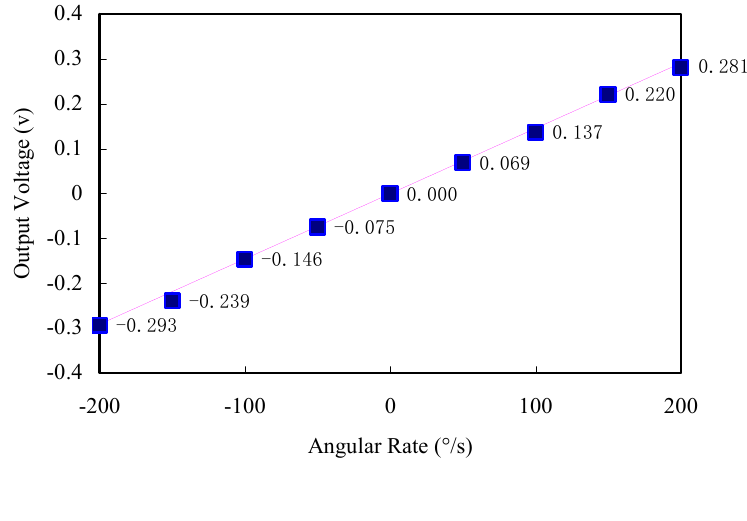
Figure 19. Output of the gyroscope versus the angular rate